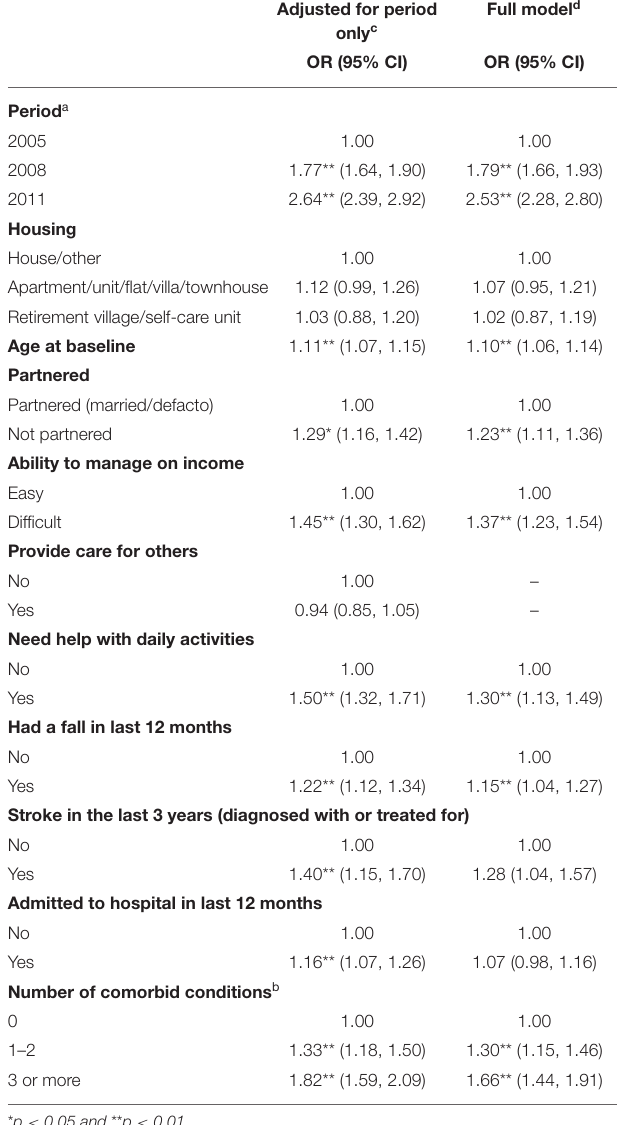
TABLE 2 | HACC services for older women in their first calendar quarter of access/use, according to housing status ( N = 4,158). HACC services used (%)